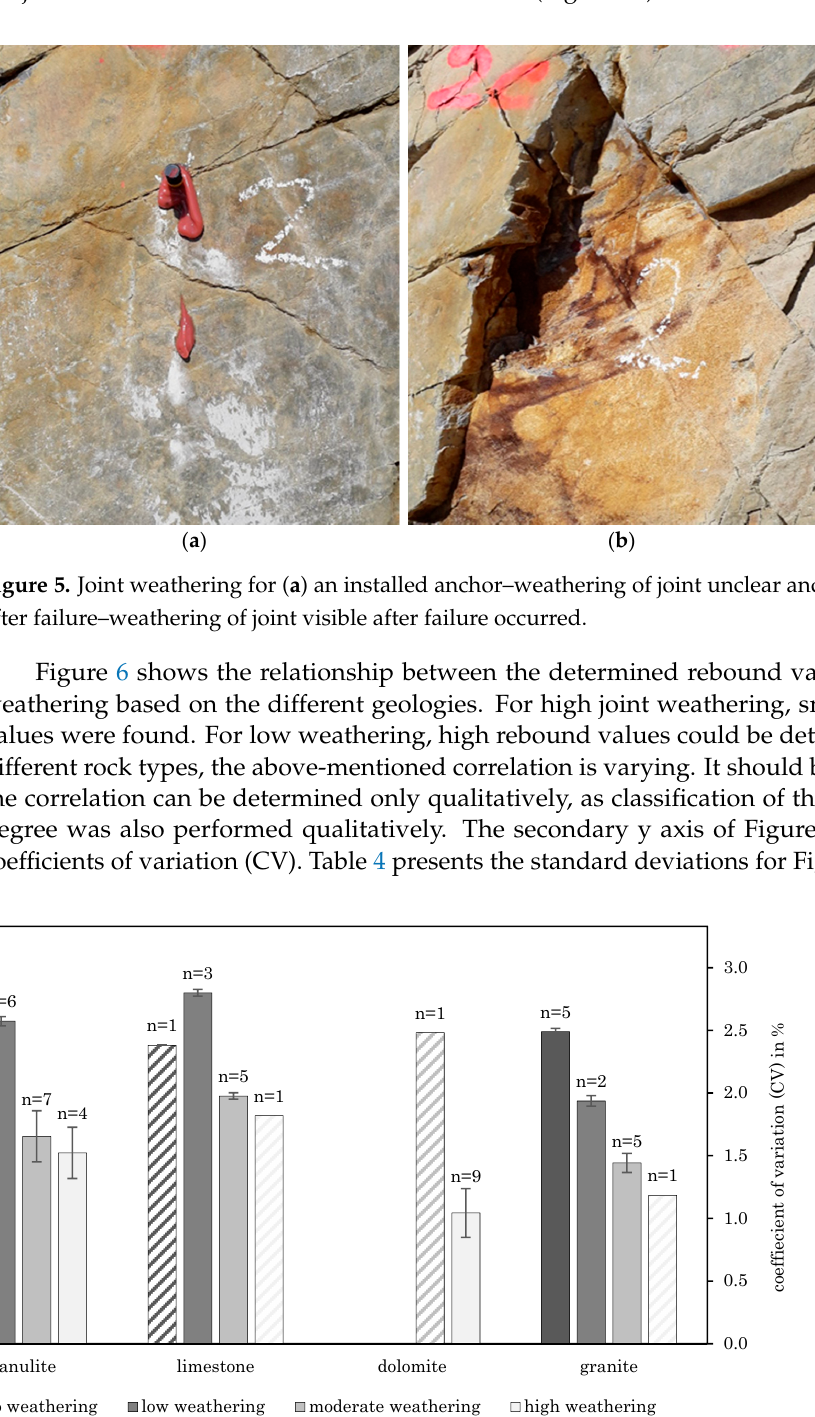
Figure 4. Failure load and CV as function of weathering class and rock type–weathering class determined after failure occurred (if n = 1 no CV is given and the beams are hatched as the data can contain an outlier). Comparing the coefficients of variation, it was found out that with low degree of weathering failure loads are not only higher but are also less scattering. Like joint quan ‐ tity, joint weathering was determined after failure occurred, too. Figure 5 indicates the reason for that, showing an installed chemical anchor where the degree of weathering of is unclear before the pull-out test is carried out (Figure 5a), although high weathering of the joint is unclear before the pull ‐ out test is carried out (Figure 5a), although high weath ‐ the joints could be observed after failure occurred (Figure 5b). ering of the joints could be observed after failure occurred (Figure 5b).